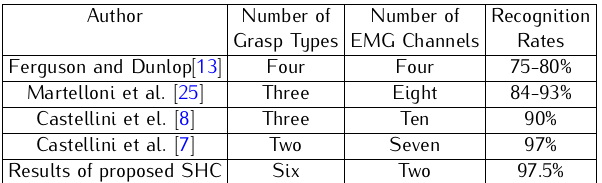
F a Table 3. Comparison of Grasp Types Recognition